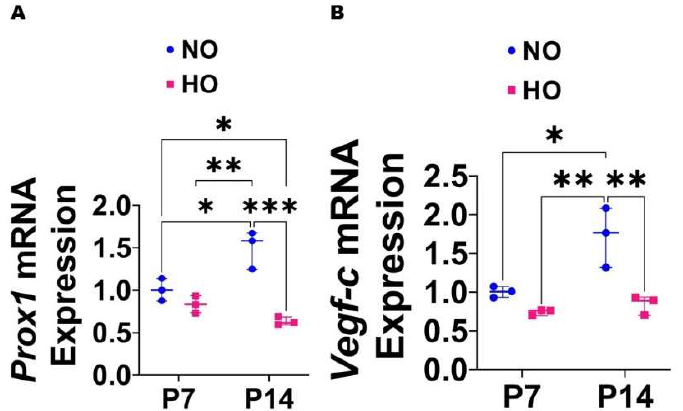
Figure 4. Expression of lymphangiogenic molecules in HO-exposed neonatal murine lungs. Gene expression studies were carried out by RT-PCR analyses on whole lung RNA isolates from WT mice exposed to NO (21% O 2 ) or HO (70% O 2 ) for 7 and 14 d. ( A – B ): the quantification of Prox1 ( A ) and Vegf-c ( B ) mRNA levels. Values are presented as the median with the range ( n = 3/group). Significant differences between exposures are indicated by * p < 0.05, ** p < 0.01, and *** p < 0.001 (ANOVA). HO exposure decreases lung lymphatic density in neonatal mice: Given the evidence that HO decreases the expression of lymphangiogenic molecules, we next investigated if this finding is associated with altered lung lymphatic density on P14. VEGFR3 + vessels were observed around larger airways and blood vessels as well in the alveolar regions (Figure 5), whereas PDPN + vessels were located predominantly around larger airways and blood vessels (Figure 6). After normalizing to the lung surface area, HO-exposed mice also had decreased VEGFR3 + (Figure 5A–D) and PDPN + (Figure 6A–D) lymphatic vessels compared with NO-exposed mice. We also observed that HO-exposed mice had reduced PDPN + (Figure 7A–D) lymphatic vessels compared with NO-exposed mice at P7. These findings indicate that HO decreases lymphatic density in the developing lungs.